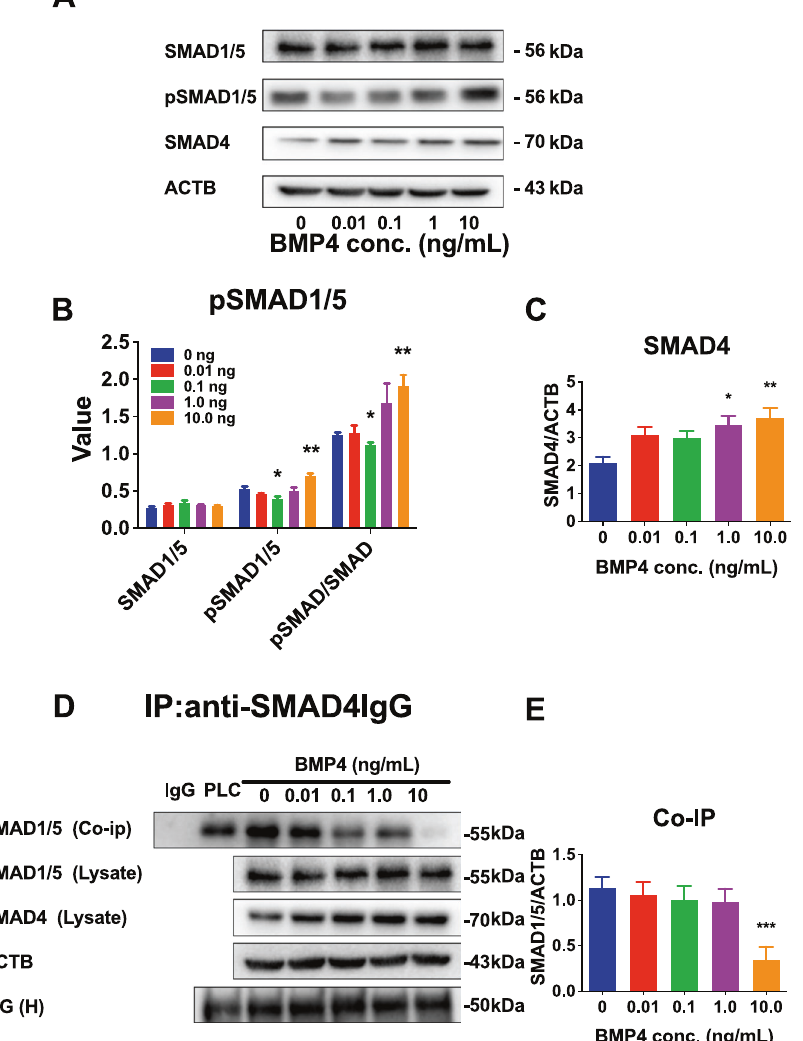
Fig. 3 BMP4 acts via the SMAD pathway in progenitor Leydig cells (PLCs) in vitro. A Western blot. B Quantitative protein levels of pSMAD1/ 5, SMAD1/5, and their ratio; Mean ± SEM, n = 3. C Quantitative levels of SMAD4; Mean ± SEM, n = 5. D Western blot for Co-P proteins; E Quantitative data of Co-IP protein levels, Mean ± SEM, n = 6. * P < 0.05 and ** P < 0.01 indicate signi fi cant differences compared to control (0 ng/mL